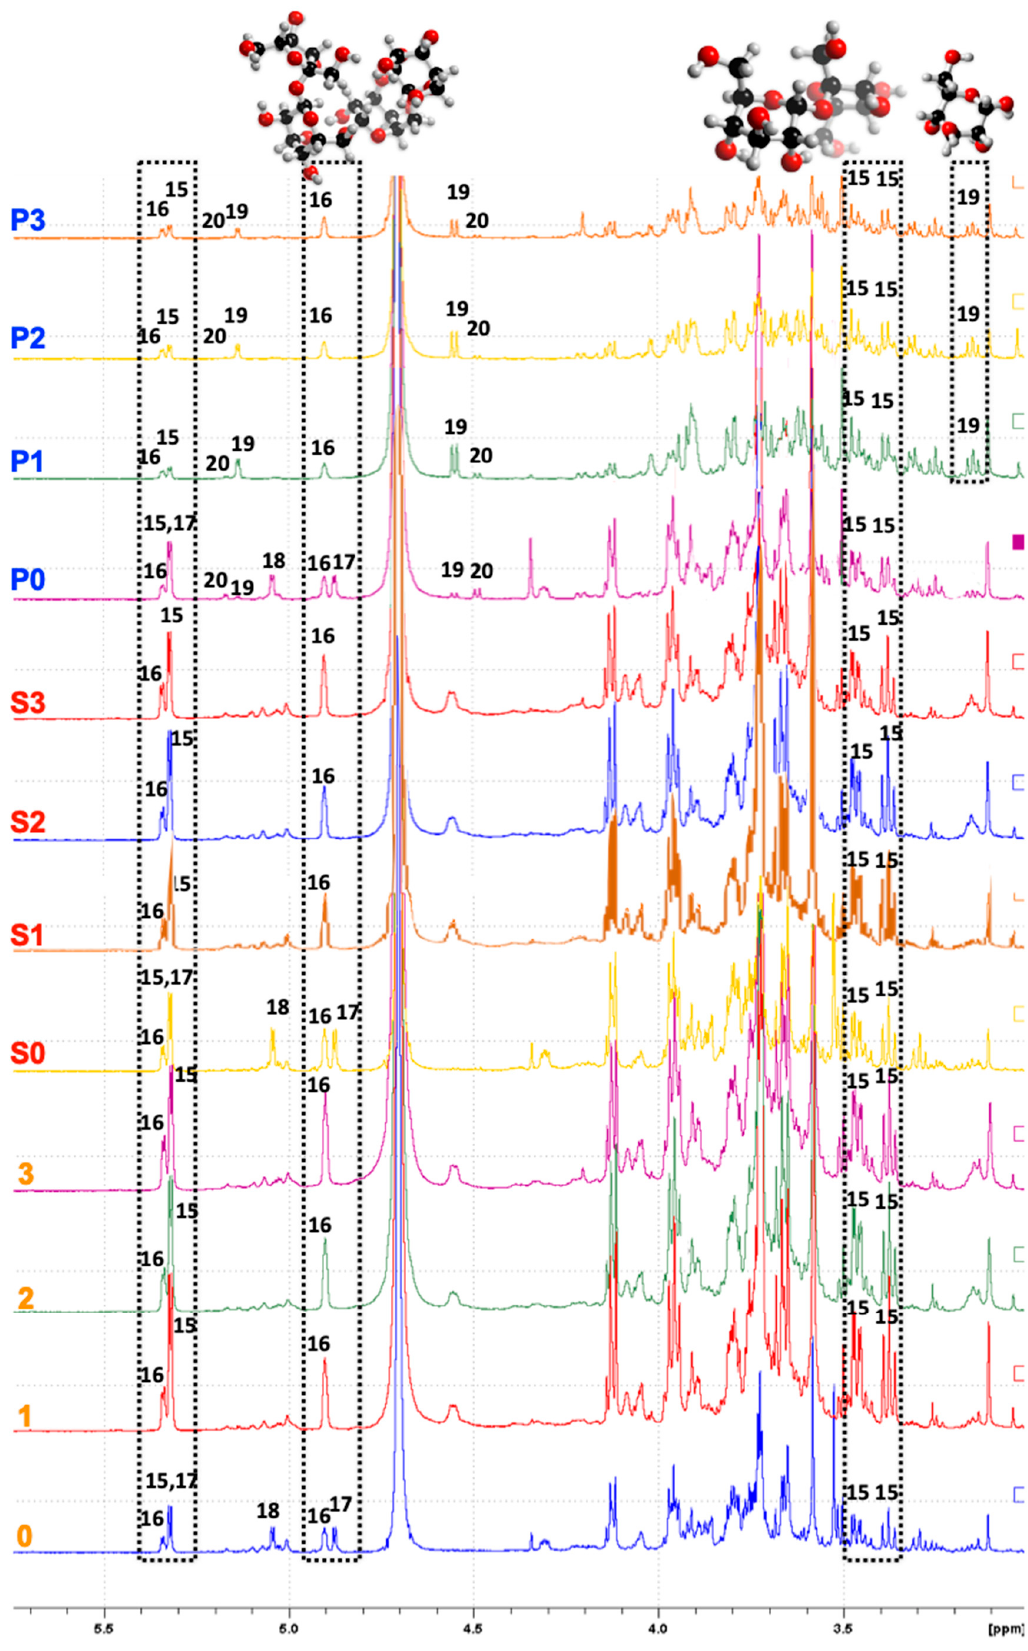
Figure 7. 1 H-NMR spectra of seed soaking waters/AQ powder samples after different treatments. Assigned peaks arise from the presence of 15, sucrose; 16, stachyose; 17, raffinose; 18, arabinose; 19, glucose; 20, galactose.